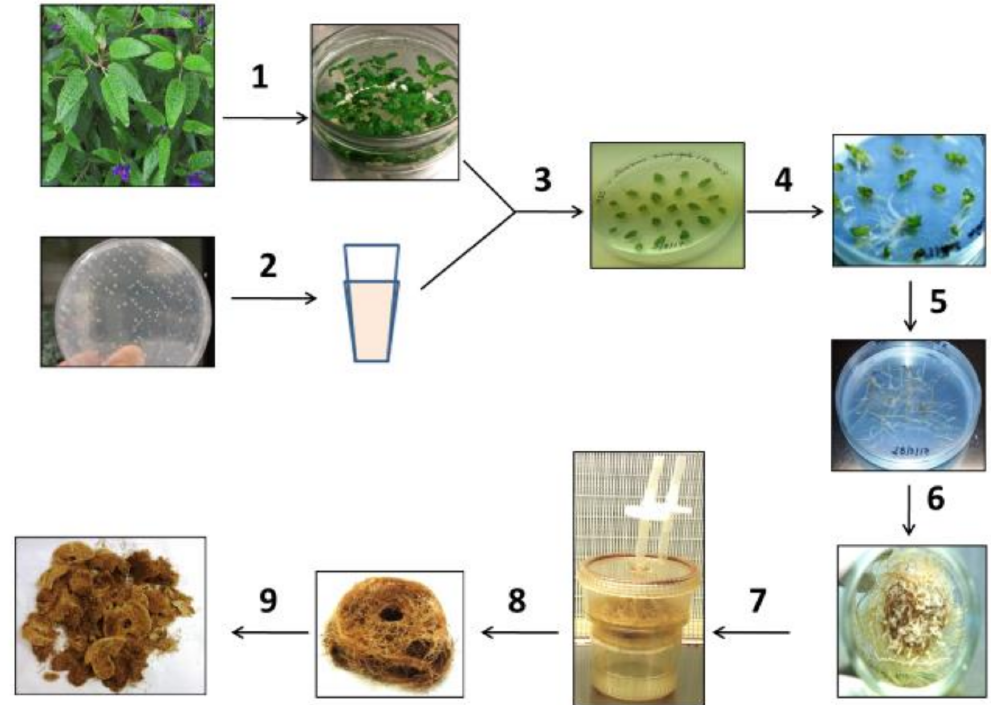
Figure 1. Scheme for obtaining the hairy roots of Salvia corrugata by transformation with A. rhizogenes . 1. Apical sterilization and in vitro growth, 2. suspension of A. rhizogenes , 3. isolation and damage of the leaves—joint incubation with A. rhizogenes for 20 min—co-culture on solid MS medium—after 3 days transfer on solid MS supplemented with cefotaxime, 4. formation of hairy roots, 5. clone selection, 6. growth in glass vessel containing liquid medium, 7. transfer into TIS bioreactors with constant renewal of the medium, 8. harvest of fresh biomass, 9. final biomass after